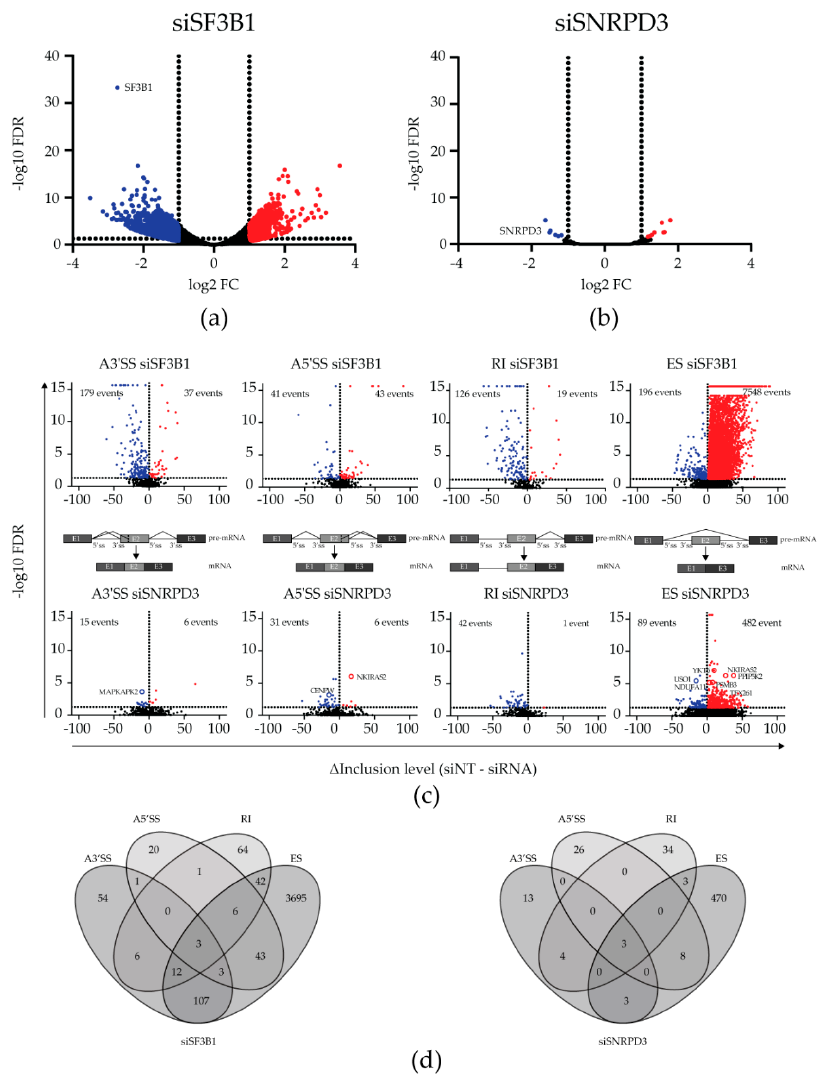
Figure 1. Transcriptomic changes upon silencing SNRPD3 compared to silencing SF3B1. ( a ) Differential expression (DE) analysis revealed 729 upregulated and 1260 downregulated genes when SF3B1 was silenced in A549 non-small cell lung cancer (NSCLC) cells (FDR < 0.05, logFC < − 1 or > 1). ( b ) In contrast to siSF3B1, only eight and six genes were up- or downregulated upon SNRPD3 knockdown, respectively (FDR < 0.05, logFC < − 1 or > 1). ( c ) Alternative splicing (AS) events (A3 (cid:48) SS, A5 (cid:48) SS, RI and ES) upon silencing SF3B1 (top) or SNRPD3 (bottom). Silencing SF3B1 led to considerably more AS events than silencing SNRPD3. ( d ) Venn diagrams showing the overlap between the types of AS events within samples. Upon SF3B1 silencing, multiple AS events occurred within the same gene, whereas SNRPD3 silencing led to mostly single AS events within